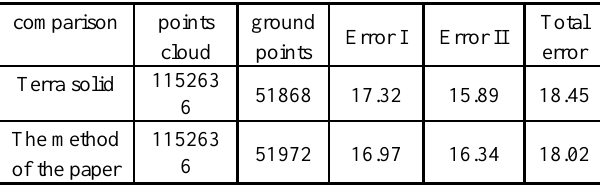
Table 7. The result comparison of